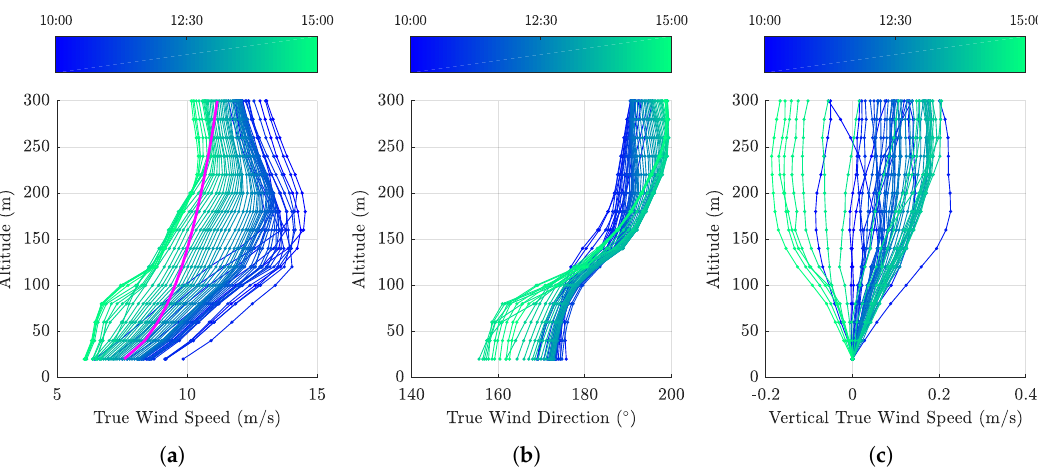
Figure 10. Example of wind speed profile ( a ), wind direction profile ( b ) and vertical wind speed profile ( c ), calculated by the weather modelling during the 29th of March, and outputted at the location of the center measurement platform (time (UTC) of each profile depends on color, and is denoted by the colorbar). The magenta line on plot ( a ) denotes the International Towing Tank Conference (ITTC) profile, calculated from the average wind of all profile at 20 m during the